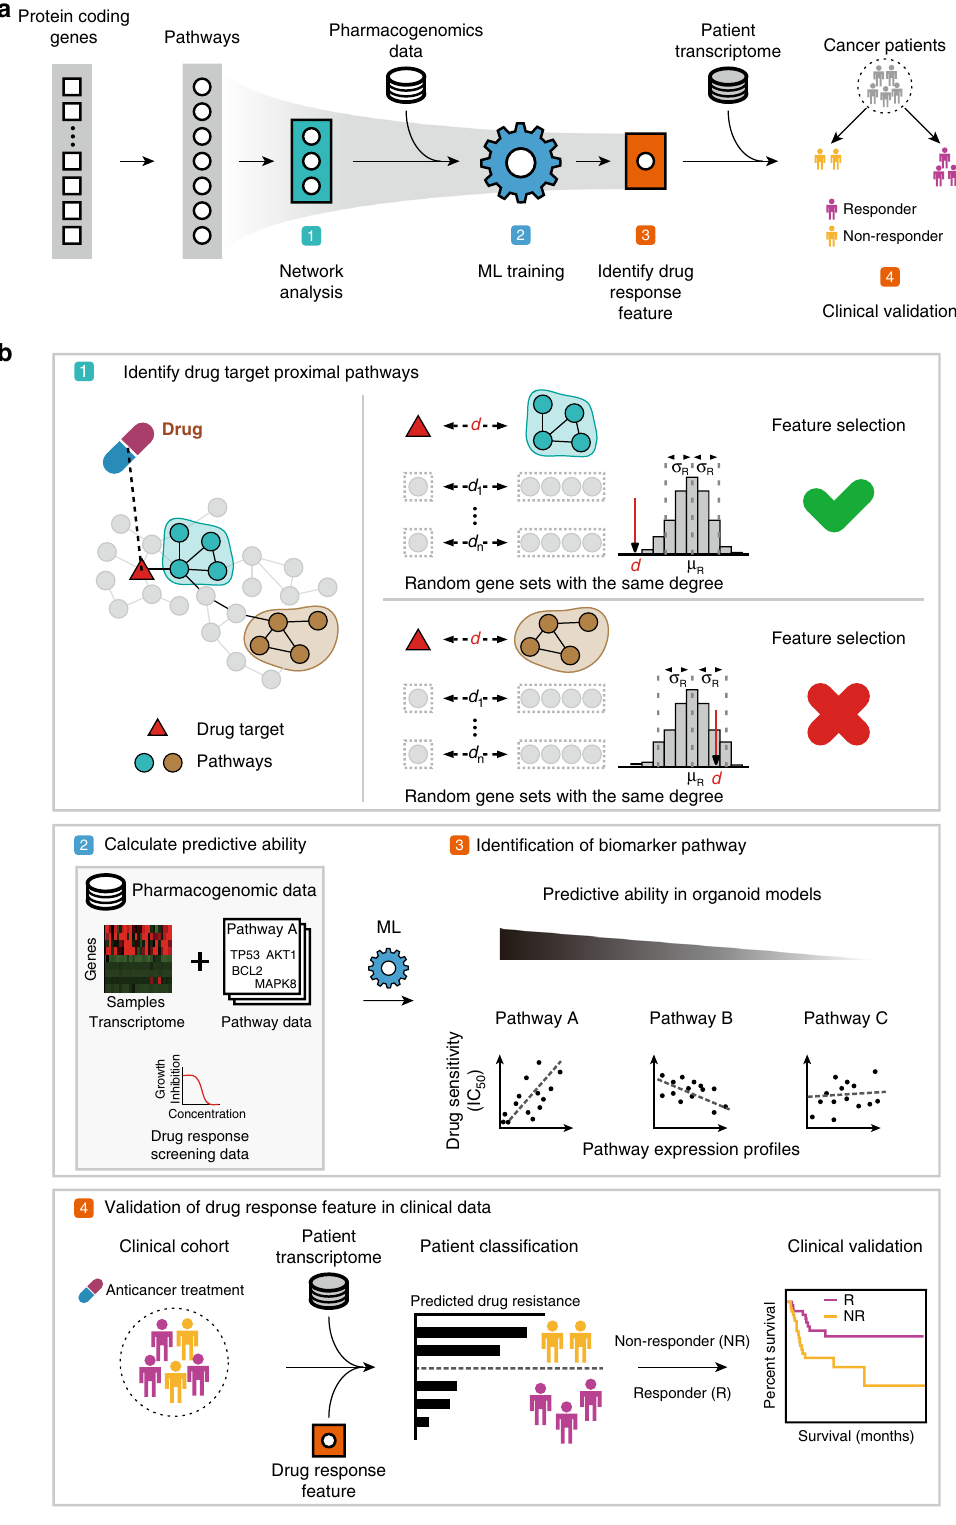
674 reactome pathways, we found 37 pathways that were prox- imal to the 5FU target in the PPI network (Fig. 2a). To measure the predictive performance of the proximal pathways against the 5FU drug response in colorectal cancer, we applied ridge regression on the expression pro fi les of proximal pathways against the 5FU IC 50 values using the colorectal organoid